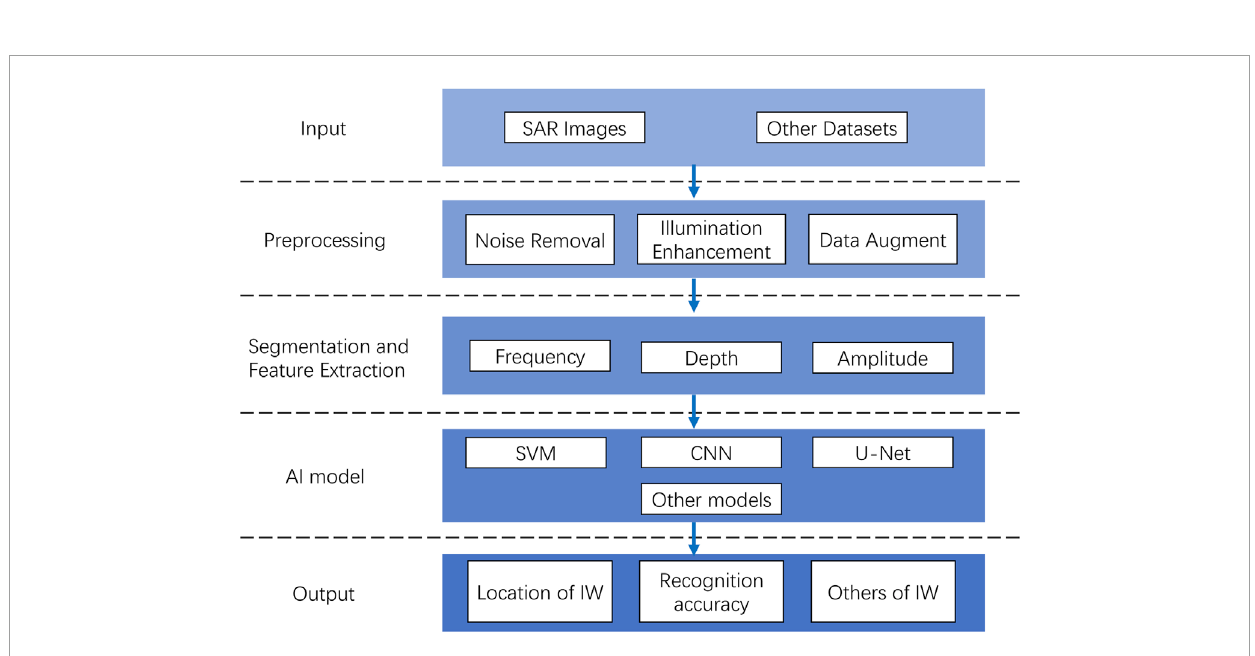
FIGURE 4 Flowchart of internal wave